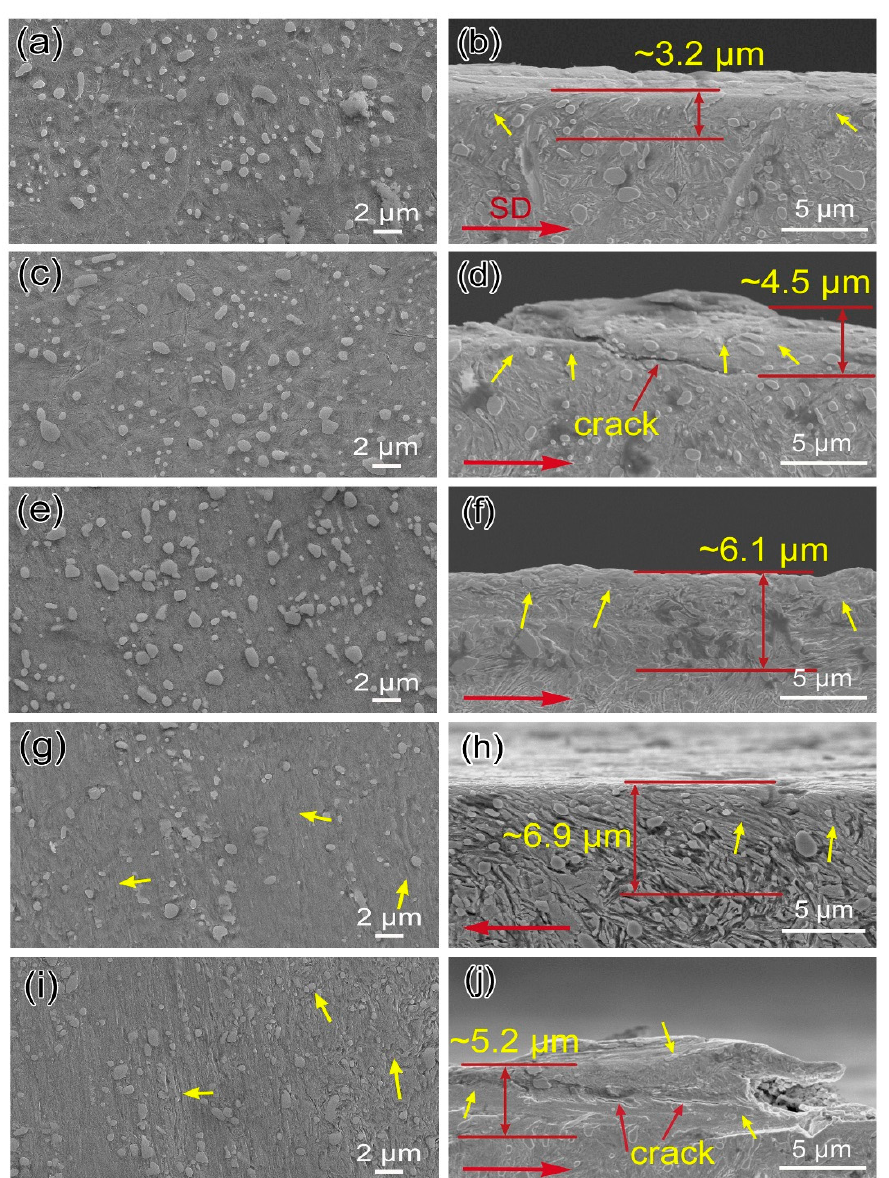
Figure 6. SEM images of typical worn surfaces and corresponding cross-section morphology for of B10 ( a ) and ( b ), B15 ( c ) and ( d ), B30 ( e ) and ( f ), B45 ( g ) and ( h ), B600 ( i ) and ( j ), under 75 N loads. Yellow arrows indicate severe plastic deformation microstructure, red parallel lines mark the approximate deformed zone, and SD indicates sliding direction.